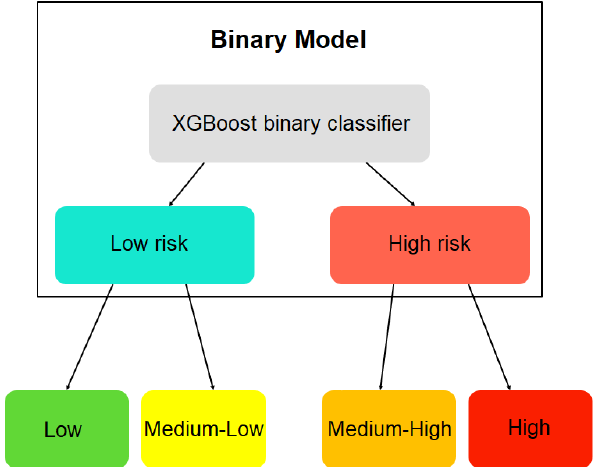
Figure 1. Proposal model for predicting the probability of rehabilitation using the retrospective cardiovascular data. It involves three stages: predicting adherence and cardiovascular risk for those patients who did not have these values, and finally predicting rehabilitation with the same machine learning approach.